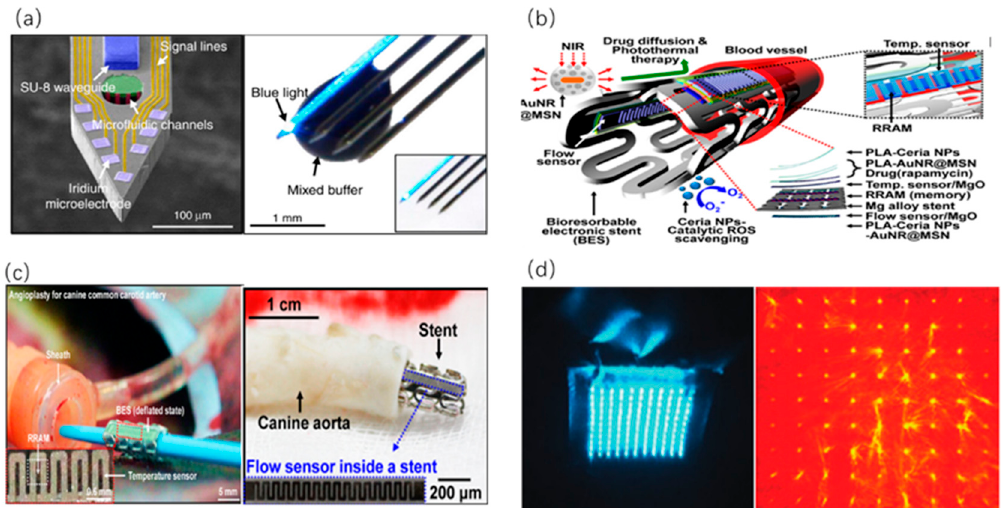
Figure 5. Integrated implantable passivity-based optical devices. ( a ) Left: Composites of top of shank 1. Right: Blue light transmission in SU-8 waveguide. Reprinted with permission from [60]. Copyright 2019, Springer Nature. ( b ) Structures of bioresorbable multifunctional electronic stent integrated with nanoparticles for therapeutic applications. Reprinted with permission from [61]. Copyright 2015, ACS. ( c ) Left: Photographs of the temperature sensor along with the bioresorbable electrical stent. Right: Photographs of the implant in the canine aorta for the ex-vivo experiment of the blood flow sensing. Reprinted with permission from [61]. Copyright 2015, ACS. ( d ) Left: Optical images of collimated 491 nm laser light transmitted through a microneedle array with a micro-lens array. Right: A transmission pattern of blue laser light (491 nm) through an optimally-aligned optical microneedle array (OMNA). Reprinted with permission from [63]. Copyright 2016, OSA.